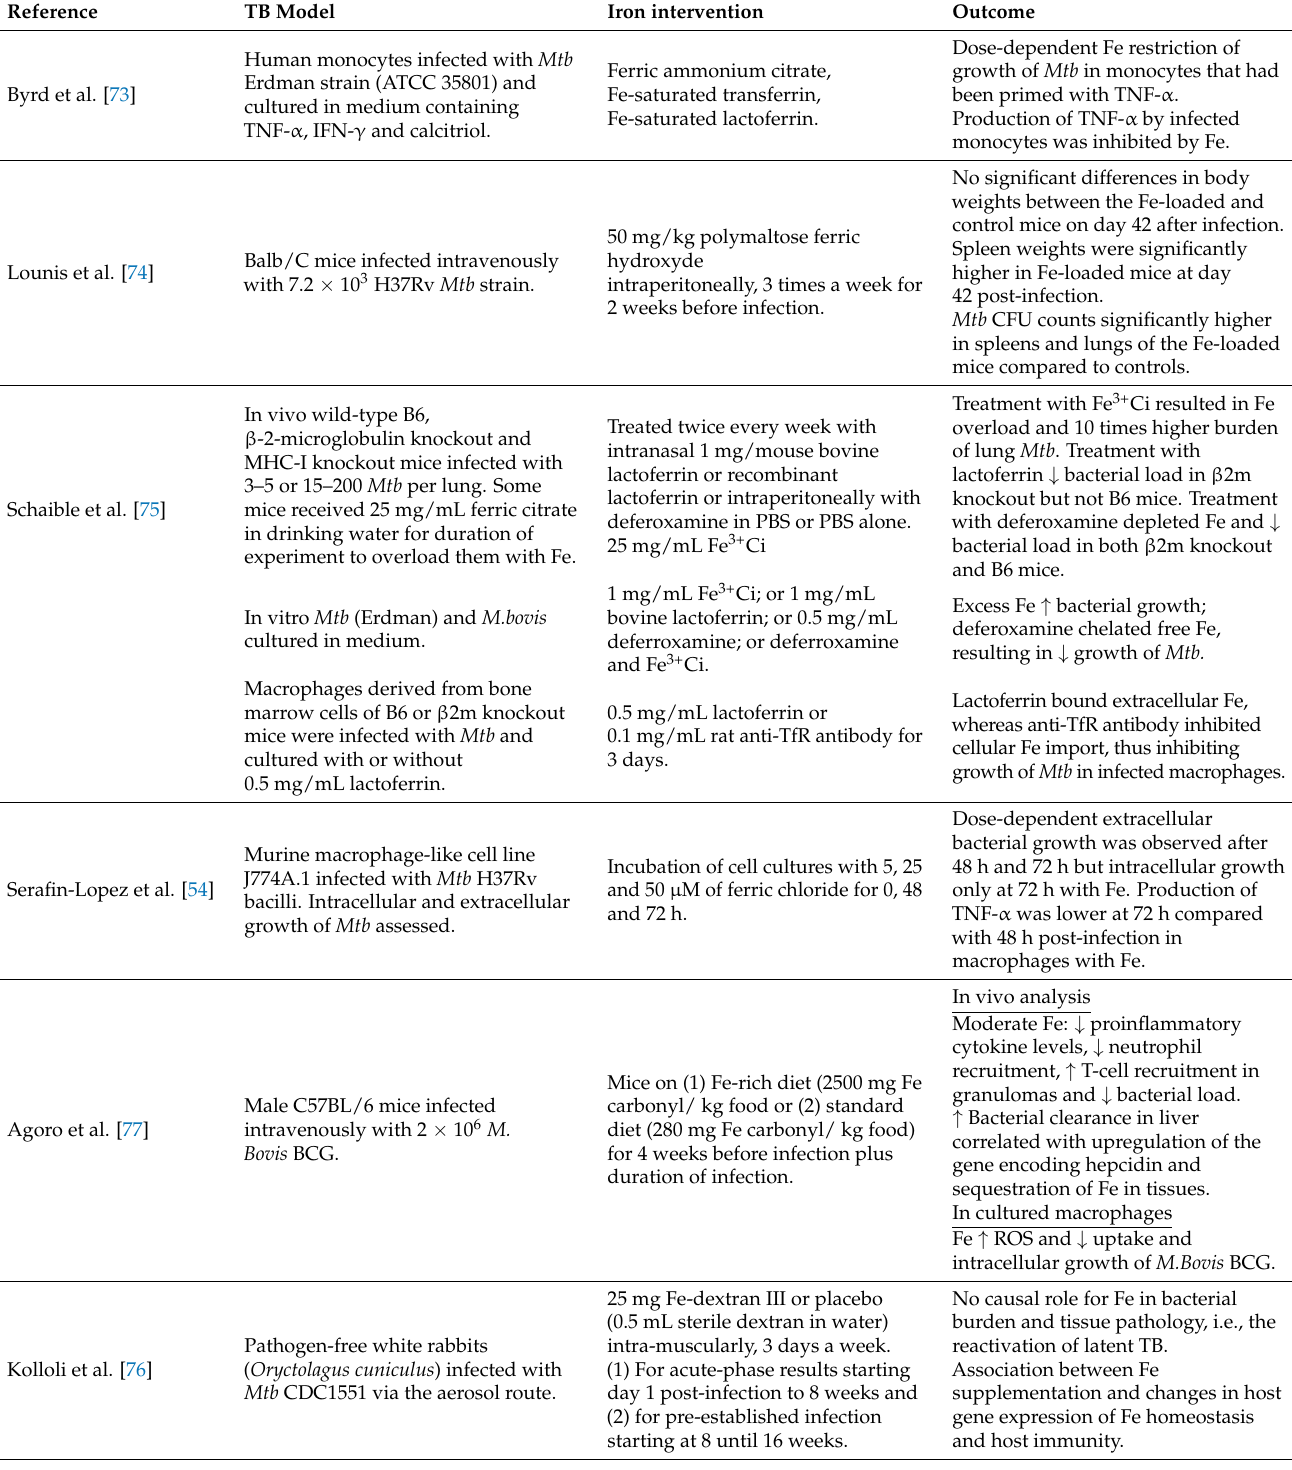
Table 2. Preclinical studies investigating the relationship between iron and